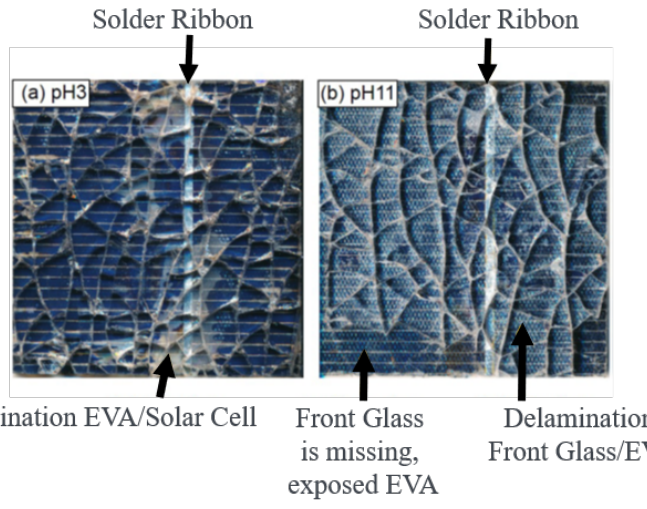
Figure 5. Photographs of c-Si module pieces with 5 × 5 cm 2 after 1.5 years of leaching in solutions with ( a ) pH 3 and ( b ) pH 11. In solutions with pH 3, a local bubble formation occurs between the solar cell and the EVA foil, preferably around the solder ribbon. In solutions with pH 11, a delamination between the EVA foil and the front glass appears across extended areas. A few parts of the glass are separated, and the exposed EVA foil with the solar cell below